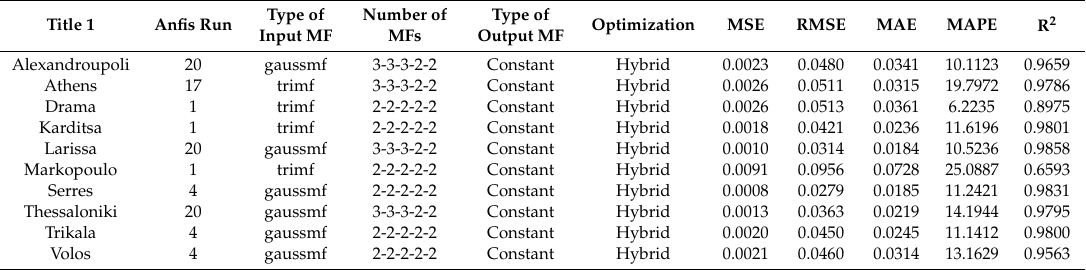
Figure 6. Forecasting results for the best three ANFIS architectures for Athens. Table 6. The best ANFIS models for all the cities under investigation (10 epochs and hybrid optimization).